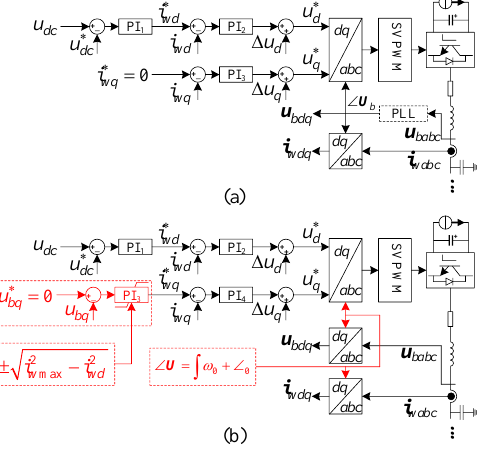
Figure 3. ( a ) Conventional vector control (VC) versus ( b ) proposed reactive power-based frequency ( Q - f ) control for voltage source inverters (VSIs) of WECSs. In actual practice, the controlled variable u bq can be replaced by the local voltage information instead of sending-end bus (SEB) voltage information. Since the critical information is the voltage-phase angle rather than the voltage amplitude, the spatial distribution feature of the voltage amplitude has litter influences on the Q - f control performance.